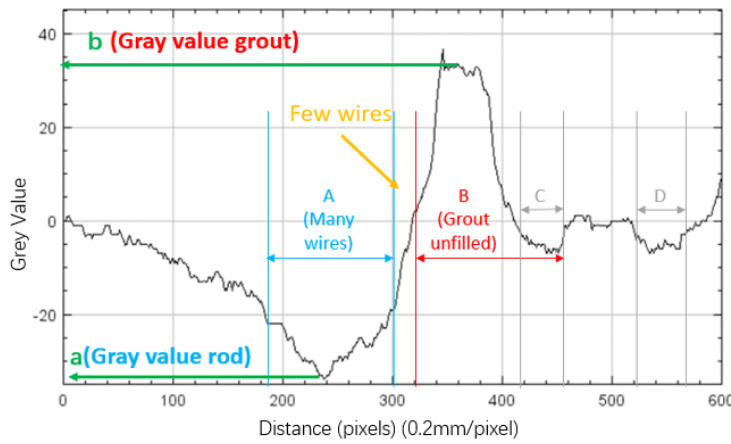
Figure 21. Original gray value profile of the yellow line in Figure 17.